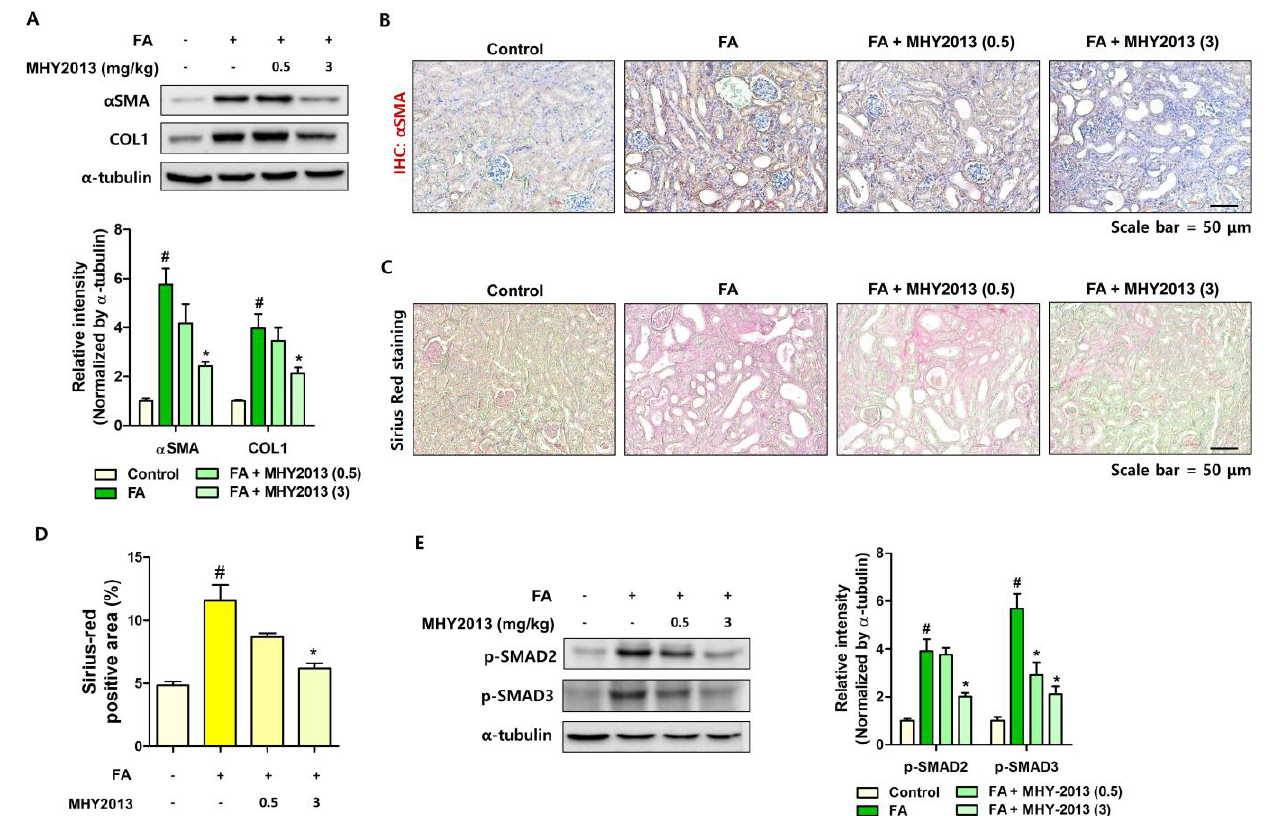
Figure 3. MHY2013 treatment reduces fibrosis-related protein expression in FA model. ( A ) α SMA and COL1 protein levels were determined in FA-treated kidneys with or without MHY2013 treatment. α -tubulin was used as a loading control. Fold change differences in protein expression were determined with densitometric analysis. # p < 0.05 vs. control groups. * p < 0.05 vs. FA group. ( B ) Representative immunohistochemical (IHC) images of α SMA expression in FA-treated kidneys with or without MHY2013 treatment. ( C ) Representative images of Sirius Red staining in FA-treated kidneys with or without MHY2013 treatment. ( D ) Positive areas for Sirius Red staining were calculated to determine the extent of fibrosis in each group. # p < 0.05 vs. control groups. * p < 0.05 vs. FA group. ( E ) Protein levels of p-SMAD2 and p-SMAD3 were determined in FA-treated kidneys with or without MHY2013 treatment. α -tubulin was used as a loading control. Fold change differences in protein expression were determined with densitometric analysis. # p < 0.05 vs. control groups. * p < 0.05 vs. FA group.